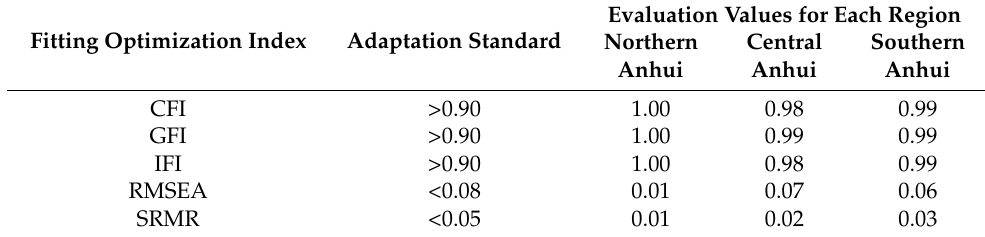
Table 5. Structural equation model fitting results.